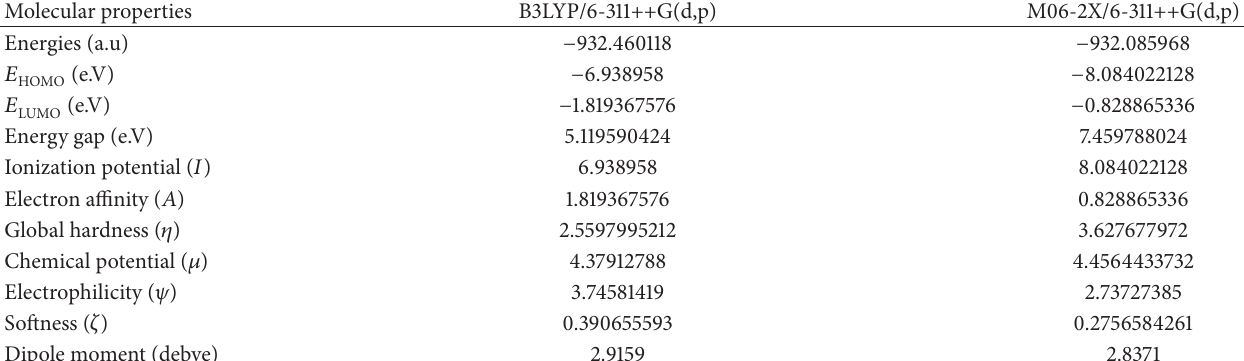
Table 3: Comparison of HOMO-LUMO energy gaps and related molecular properties of 2 .